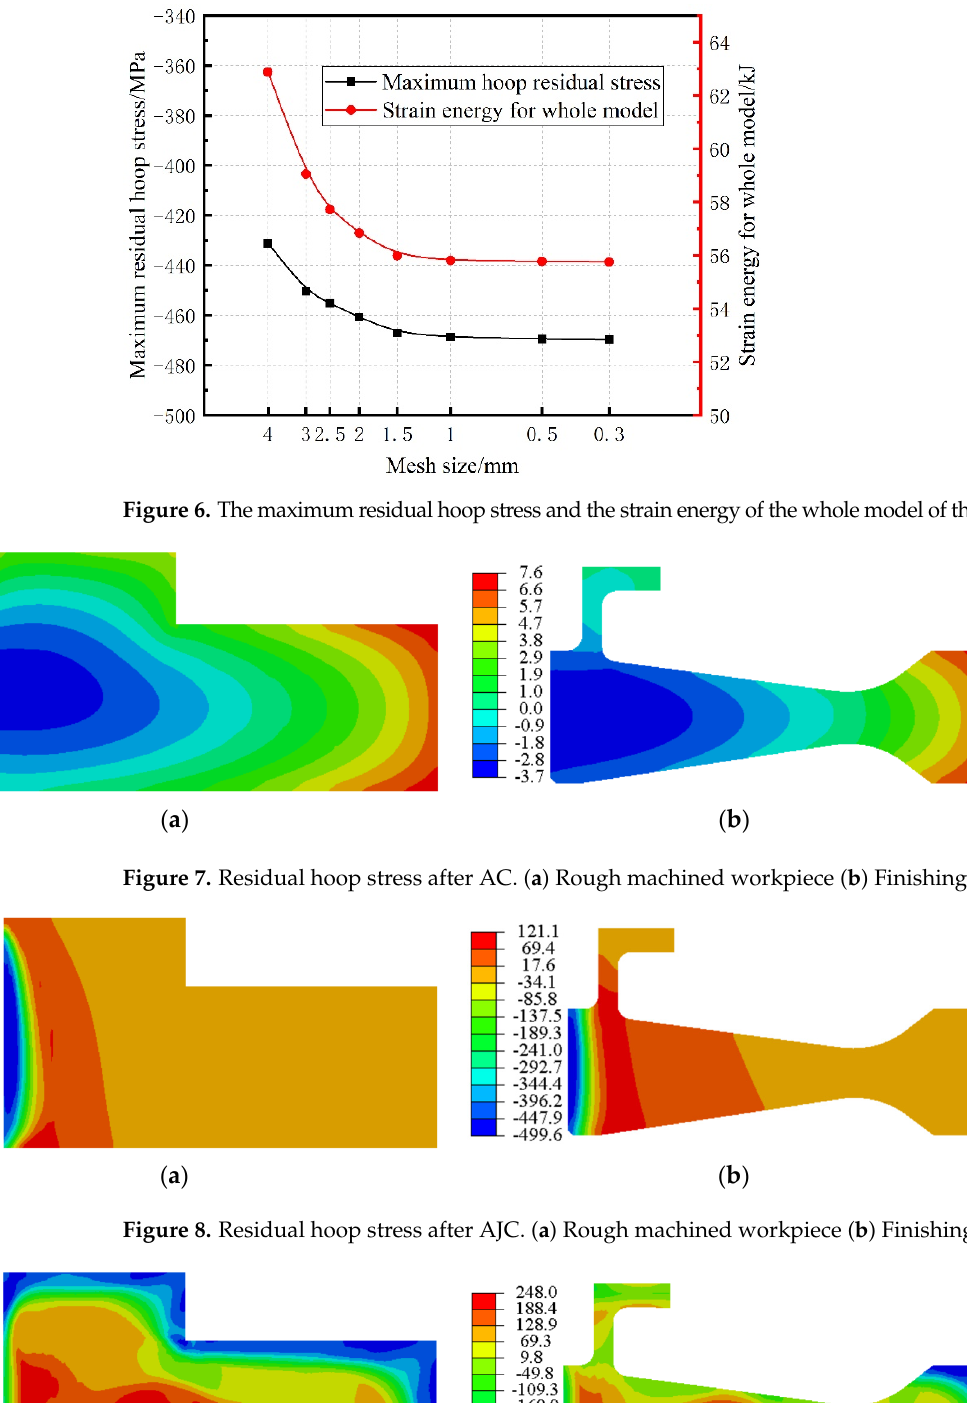
Figure 6. The maximum residual hoop stress and the strain energy of the whole model of the WQ method.